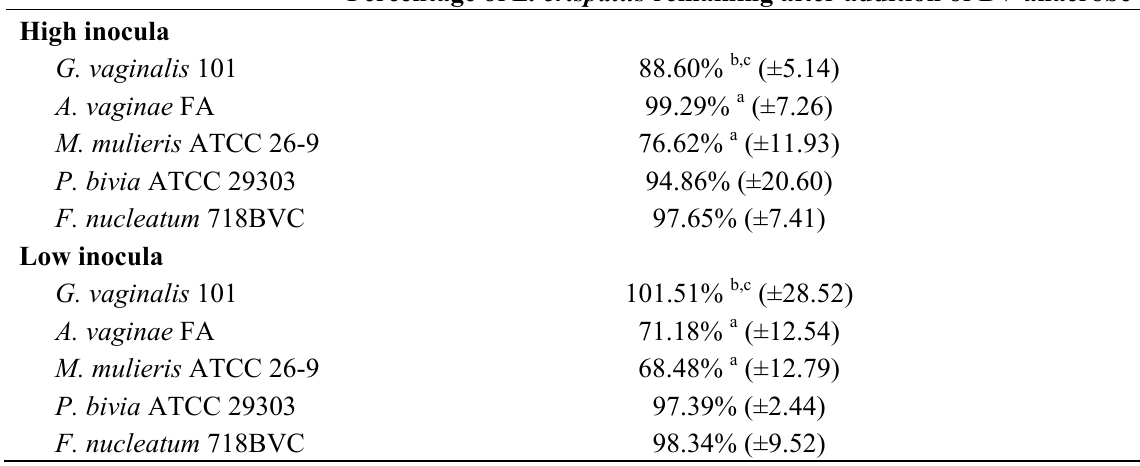
Table 2. Displacement of adherent L. crispatus by BV-associated anaerobes. Following the addition of a BV-associated anaerobe, the number of remaining L. crispatus was counted and compared to the L. crispatus control counting (7.36 × 10 7 ± 9.97 × 10 4 ). The percentage (±standard deviation) of L. crispatus that remained adherent after addition of each BV anaerobe at high or low inocula is shown